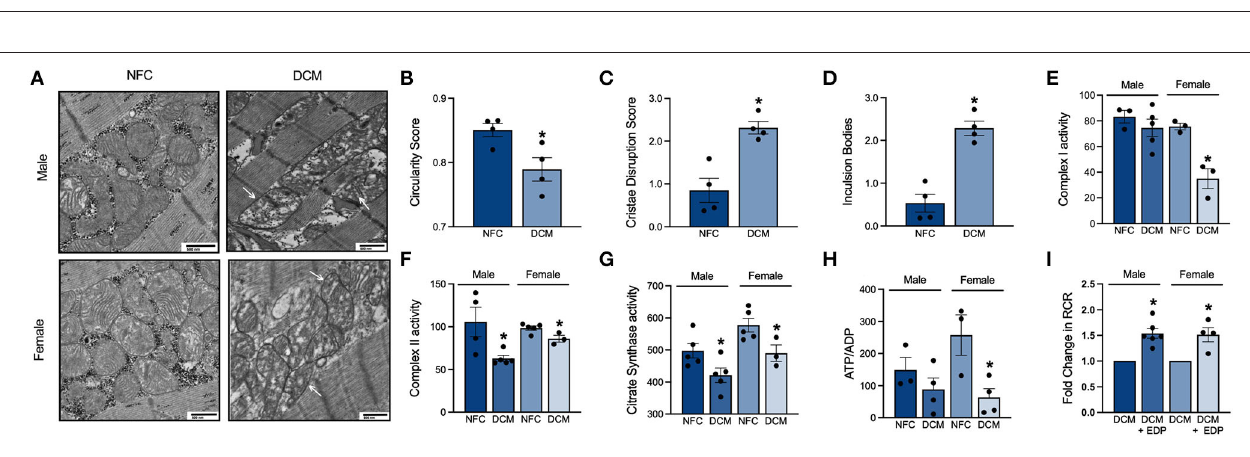
FIGURE 2 | (A) Representative images of mitochondrial morphology and distribution in heart slices by transmission electron microscopy. White arrows indicate damaged mitochondria in DCM heart slices (10,000 × magnification, scale bar = 500nm). (B) Mitochondrial circularity score. (C) Mitochondrial cristae disruption score. (D) Average number of mitochondrial inclusion bodies. Specific enzymatic activities of mitochondrial electron transport chain (E) complex I; (F) complex II; and (G) citrate synthase in nmol/(min*mg) protein. (H) Relative ATP to ADP ratio in LV tissue. (I) Mitochondrial oxygen consumption represented by the respiratory control ratio (RCR) in basal and ADP-stimulated cardiac fibers. Data are expressed as mean ± SEM and analyzed using one-way ANOVA with Tukey’s multiple comparisons test (each individual patient heart = n , male NFC n = 6, female NFC n = 6, male DCM n = 6, female DCM n = 6, * p < 0.05 vs.